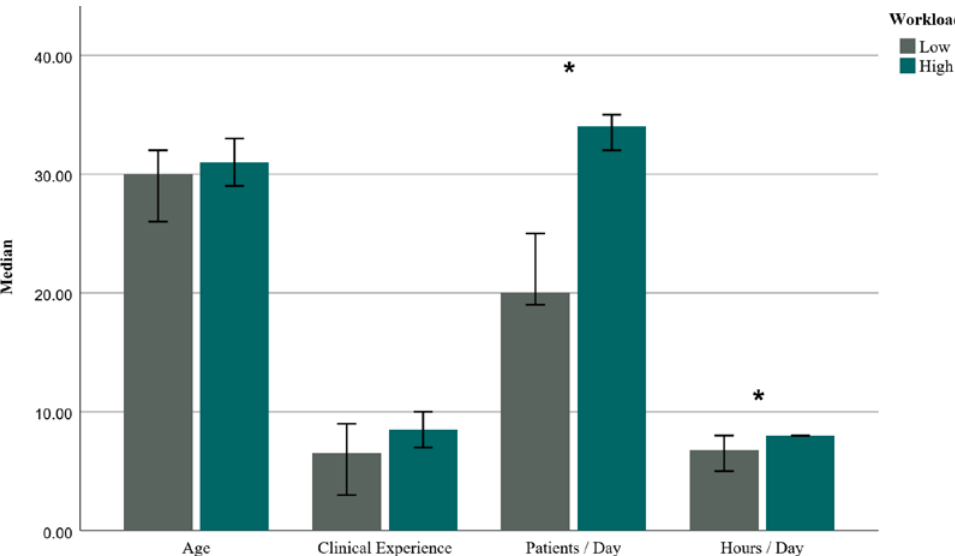
Figure 1. Between group comparison for age (years), clinical experience (years), number of treated patients daily (number of patients) and daily working hours (hours). Considering burnout and its dimensions, participants with higher workload reported a median of 4.00 in physical fatigue, a median of 2.40 in cognitive weariness, a median of 1.33 in emotional exhaustion and a median of 2.44 in the global burnout score. Participants with lower workload reported a median of 2.75 in physical fatigue, a median of 1.40 in cognitive weariness, a median of 1.00 in emotional exhaustion and a median of 1.58 in the global burnout score. Significant differences were found between participants with high and low workload regarding physical fatigue (p = 0.003), cognitive weariness (p = 0.048) and global burnout score (p = 0.003) (Figure 2).